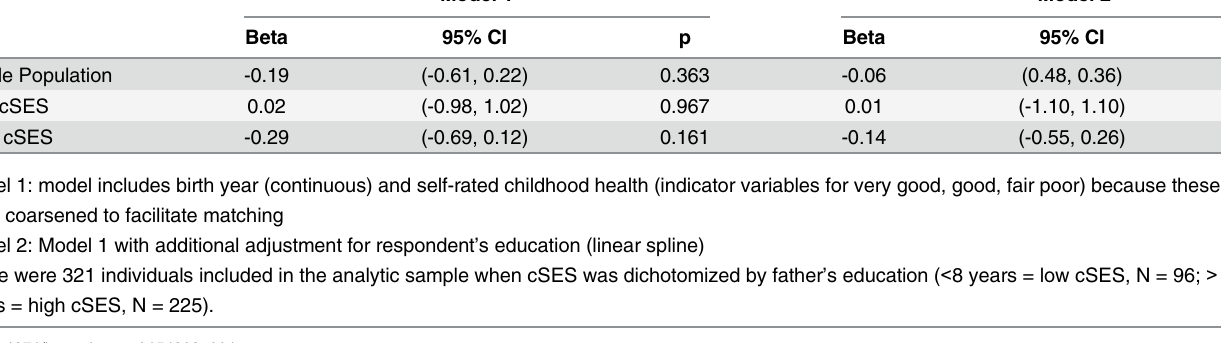
Table 4. Results for number of depressive symptoms among GI Bill eligible veteran wives compared to non-veteran wives when cSES is dichoto- mized by father ’ s education.